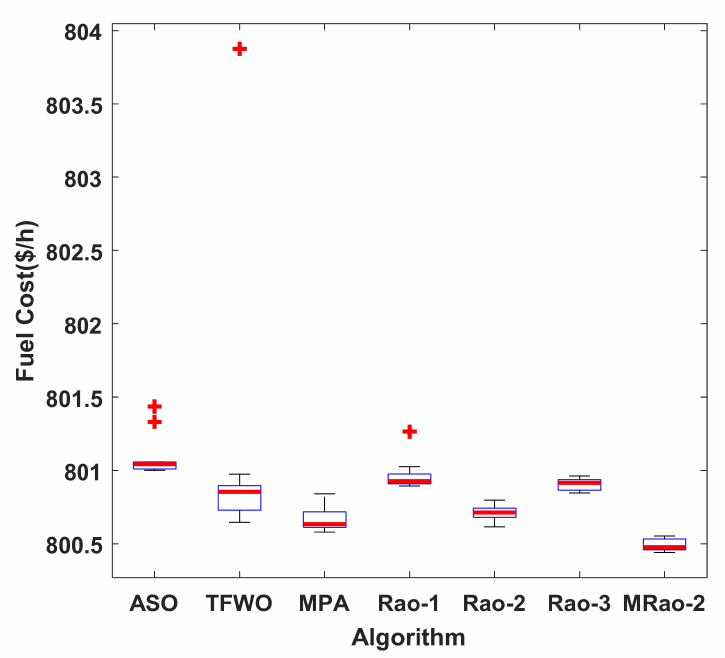
Figure 6. Boxplot graph of best Fuel cost in 20 runs of the proposed MRao-2 and other recent algorithms for case